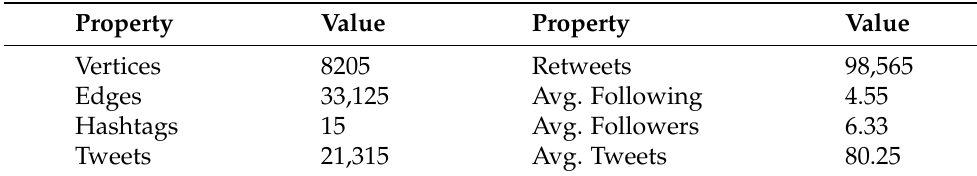
Table 2. Subgraph